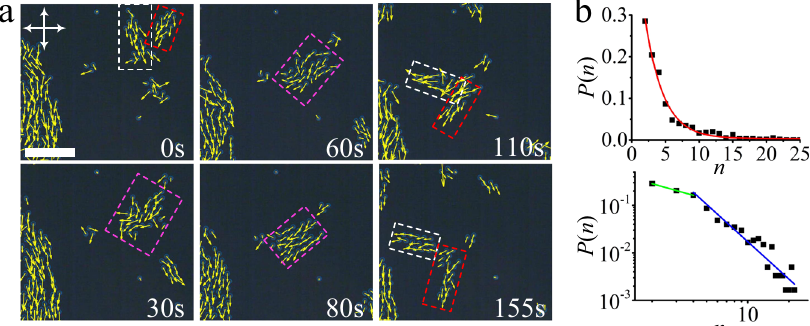
Fig. 4 Directron fl ocks. a Polarizing micrographs of fusion and fi ssion of directron fl ocks at different times. Directron fl ocks are indicated by dashed squares with different colors. Scale bar 100 μ m. The crossed polarizers are indicated as white arrows. U = 15.4 V, f = 100 Hz. b Frequency distribution of directron fl ock sizes (number of individual directrons, n , in each fl ock) at U = 15.5 V, f = 100 Hz. The top fi gure demonstrates the probability of fi nding a directron fl ock composed of n directrons. The red line represents the exponential fi t of the experimental data (black squares). The bottom fi gure shows the log-log plot of the distribution. The green and blue lines are linear fi ts of the experimental data with slopes β 1 = − 0.8 and β 2 = − 2.6, respectively.